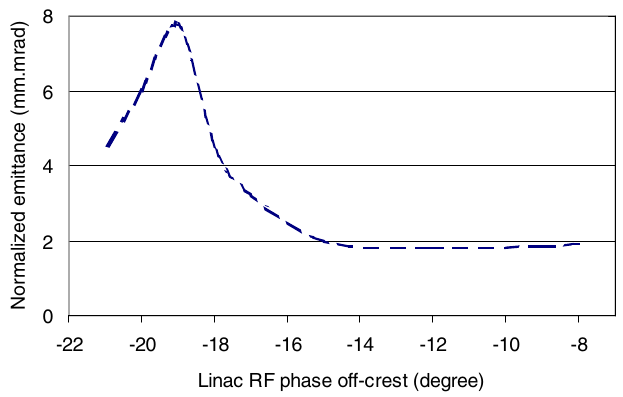
FIG. 2. (Color) Measured normalized transverse emittance vs linac’s rf off-crest phase (note that the minimum energy spread was achieved at the linac’s rf off-crest phase of (cid:6) 8 (cid:3) ).